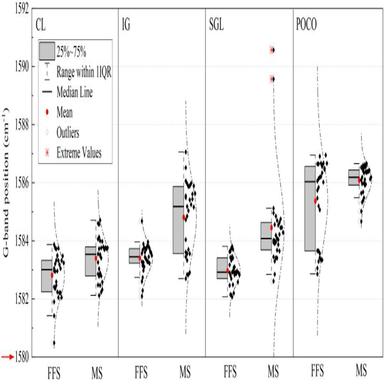
Raman G-band position boxplot obtained from both MS and FFS. Each box is derived from 30 G-band position values, with the reference G-band position from stress/strain-free state being 1580 cm−1 (indicated by the red arrow) . (For interpretation of the references to colour in this figure legend, the reader is referred to the web version of this article.)